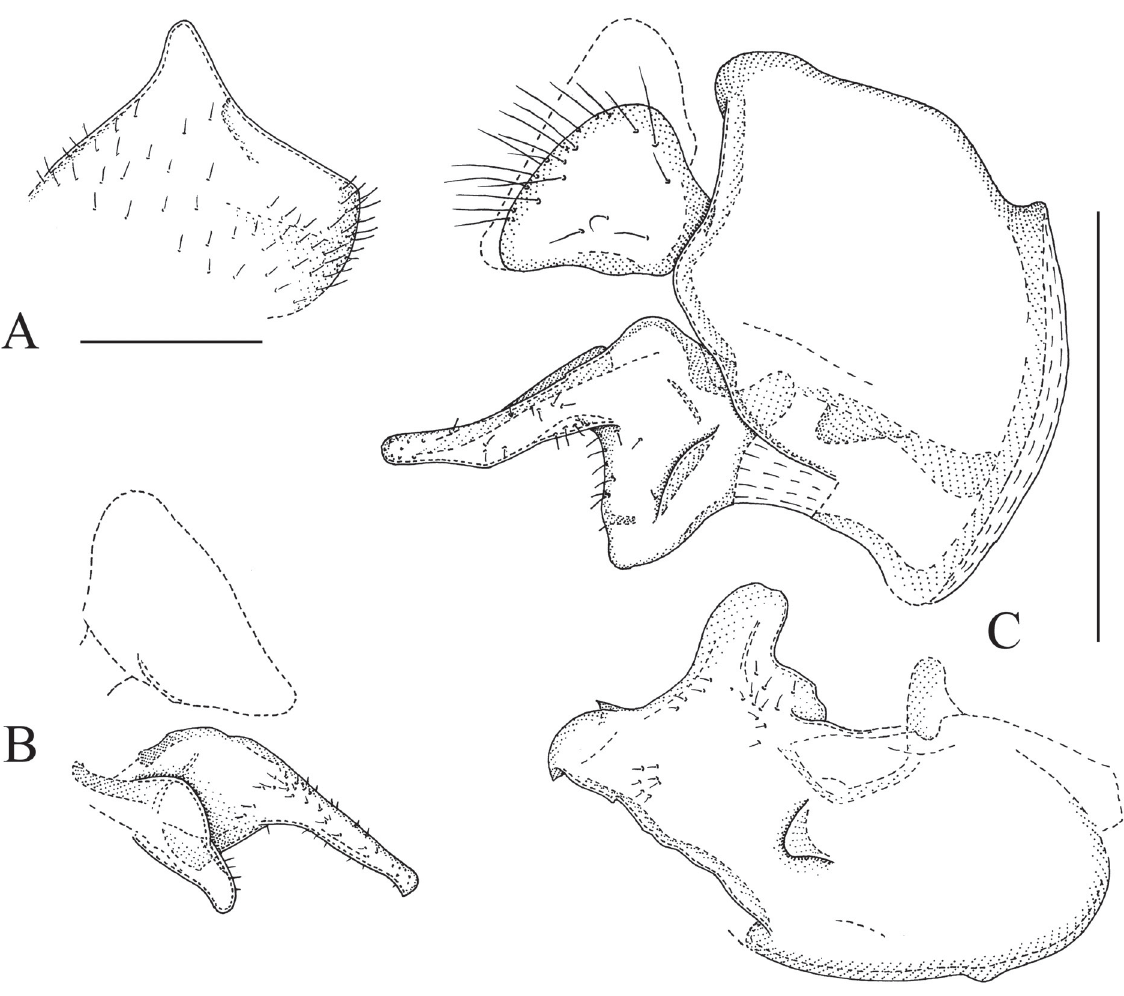
Fig. 31. Sphegina (Asiosphegina) farinosa sp. nov., holotype, ♂ . A . Posterior part of sternum IV, latero- ventral v iew. B . Left cersus and surstylus, lateral view. C . Genitalia, right side, lateral view. Scale bars = 0.5